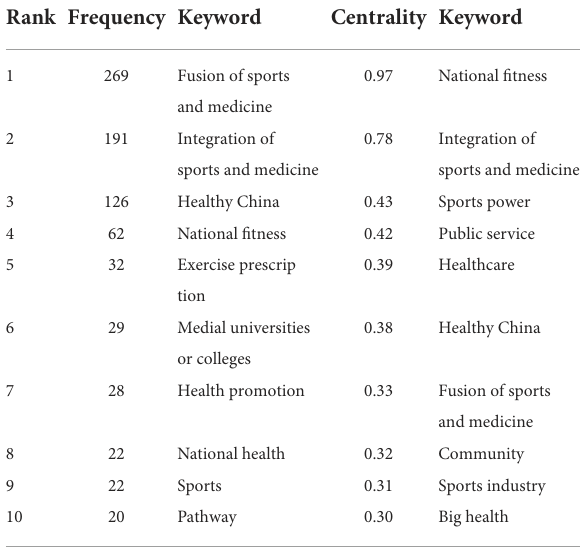
TABLE 4 The top 10 keywords of fusion of sports and